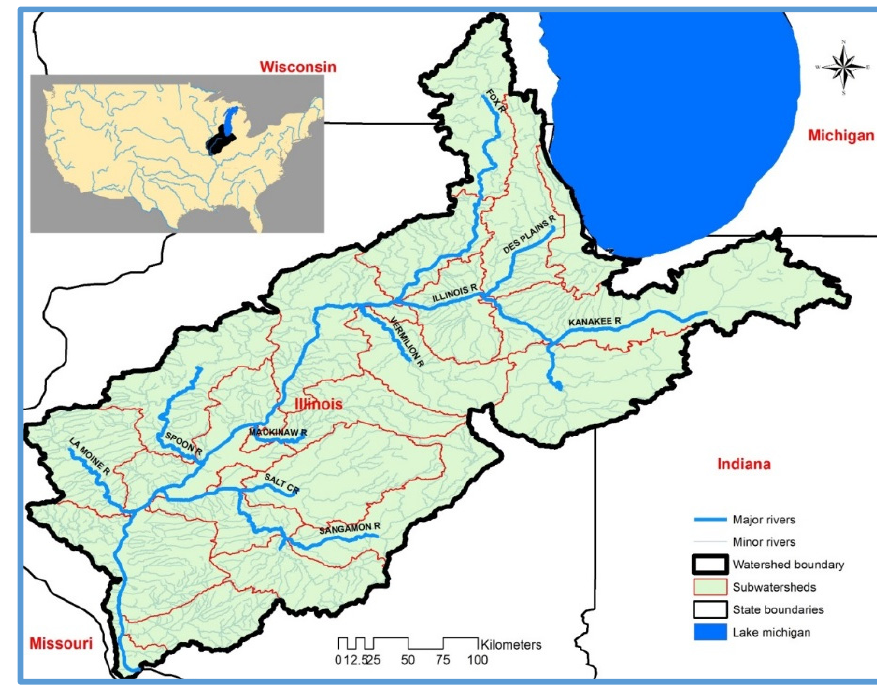
Figure 9. Location of the Illinois River Basin (IRW).